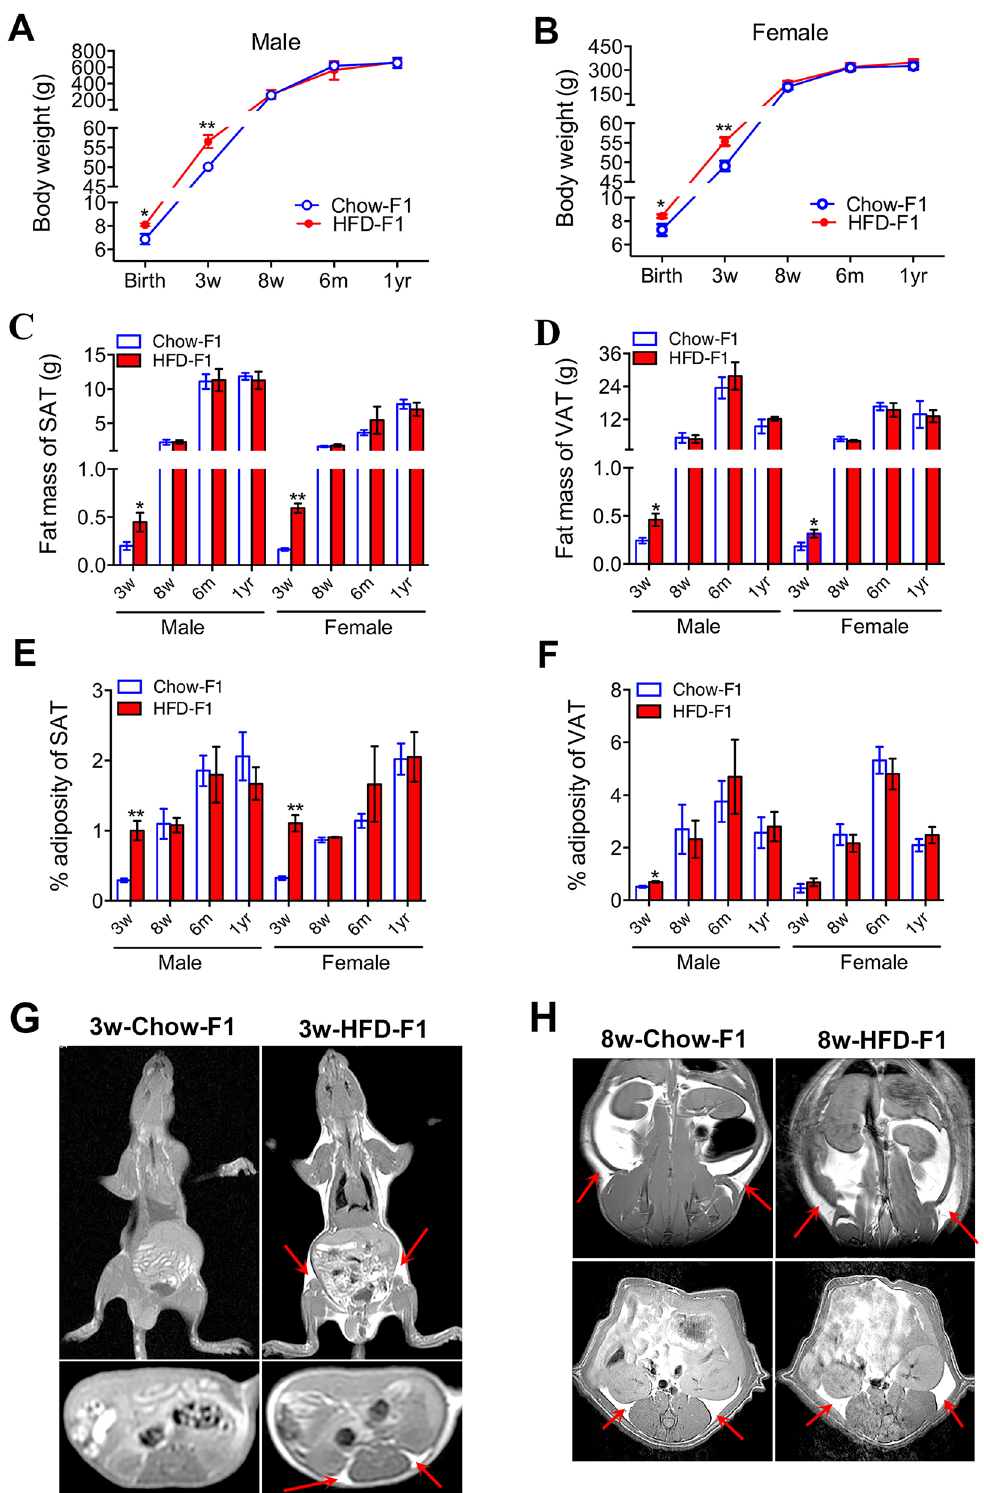
Figure 1. Body weight and fat mass between chow-exposed and HFD-exposed rat offspring at different ages. ( A ) Body weights of male chow-exposed and HFD-exposed rat offspring of various ages. ( B ) Body weights of female chow-exposed and HFD-exposed rat offspring of various ages. ( C ) Fat mass of subcutaneous adipose tissue (SAT) in male and female offspring. ( D ) Fat mass of visceral adipose tissue (VAT) in male and female offspring. ( E ) % adiposity (fat/body weight) of SAT in male and female offspring. ( F ) % adiposity of VAT in male and female offspring. ( G ) T1-weighted magnetic resonance (MR) images in 3-week-old chow-exposed and HFD-exposed male rat offspring. ( H ) T1-weighted MR images in 8-week-old chow-exposed and HFD-exposed male rat offspring. For ( A – F ), values are expressed as means ± SEs, n = 6 for each group. ** p < 0.01, * p < 0.05, compared to the corresponding control. For E and F, the images above were obtained in the coronal plane; the images below were obtained in the transverse section. The arrows indicate fat distribution in subcutaneous and visceral adipose